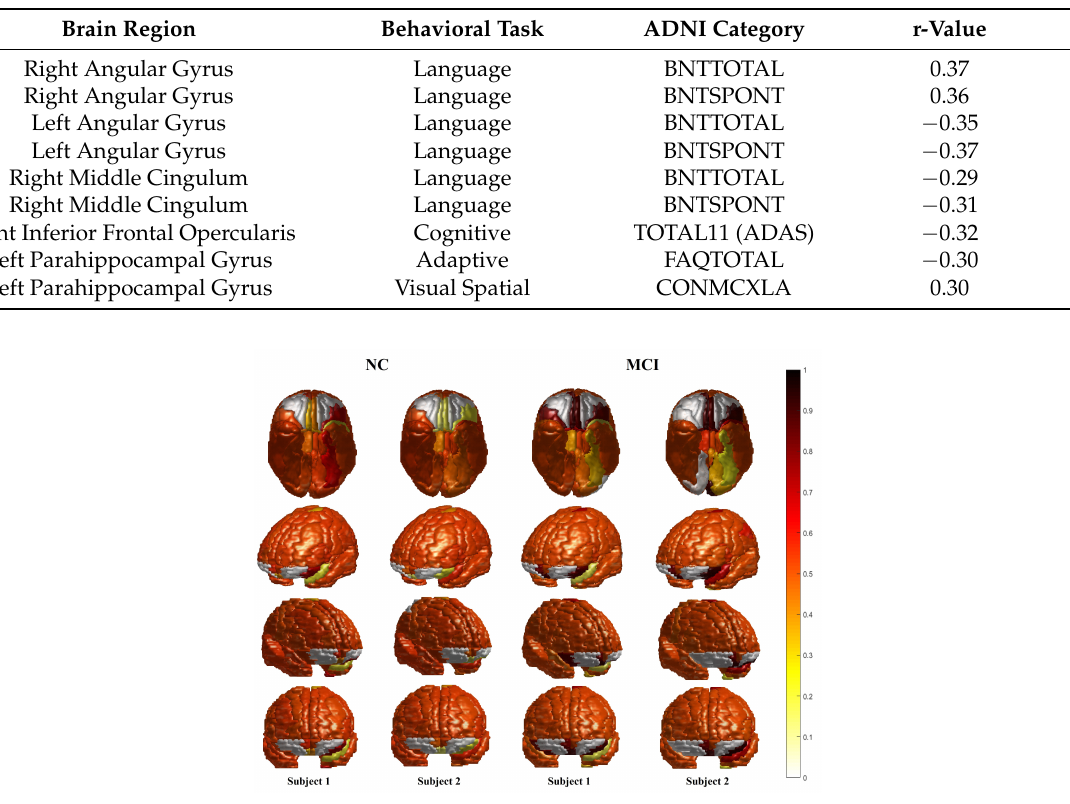
Figure 6. Different examples that show the cortical regions diagnosis for two different normal, and two different mildly cognitive subjects. Note: (1) the color-bar-based gradient colors represent the disease’s severity in every studied region separately. (2) The blue arrows show examples of the cortical regions that show significant difference in the probabilistic diagnosis results between the NC and MCI